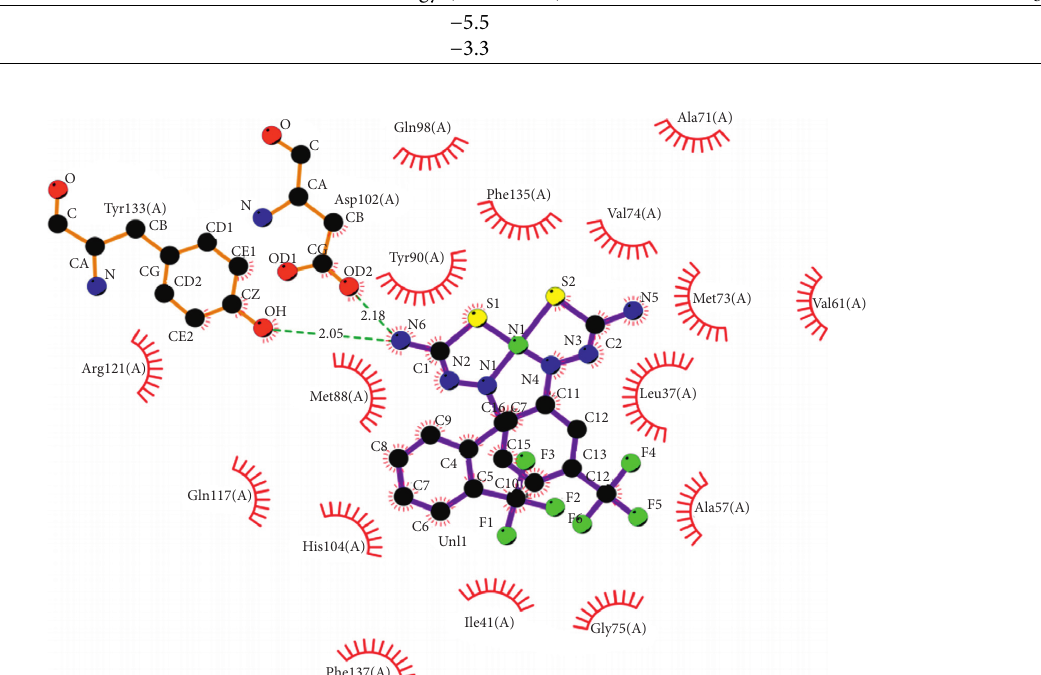
Table 5: Binding affinities (Kcal mol − 1 ) and number hydrogen bonds ( H Substrate